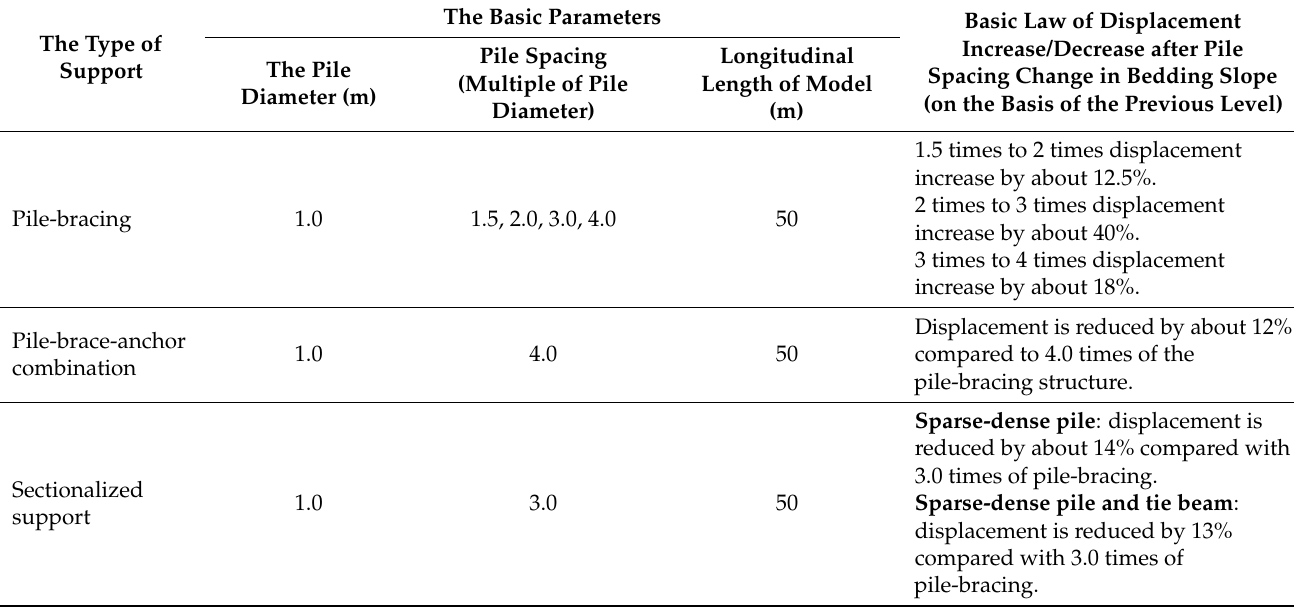
Table 4. Analysis results of rock slope support.